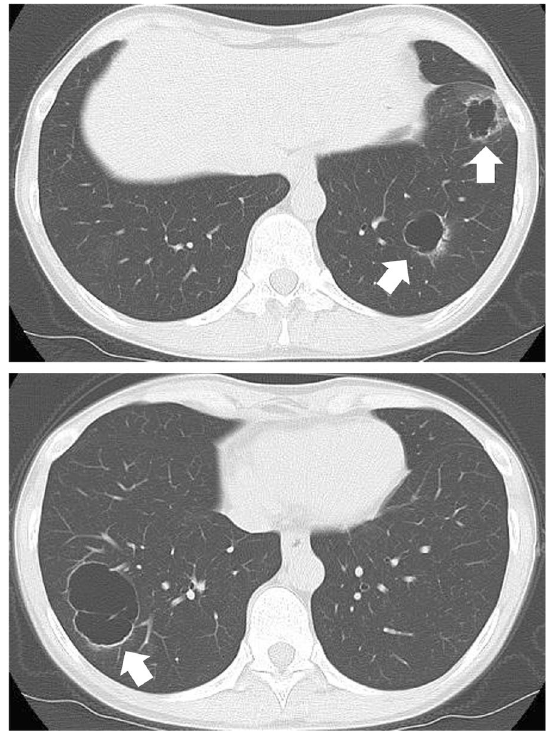
Fig. 1 Plain chest computed tomography scans 3 years and 6 months after the initial surgery. Multiple cystic lesions were found in both lungs (white arrow)